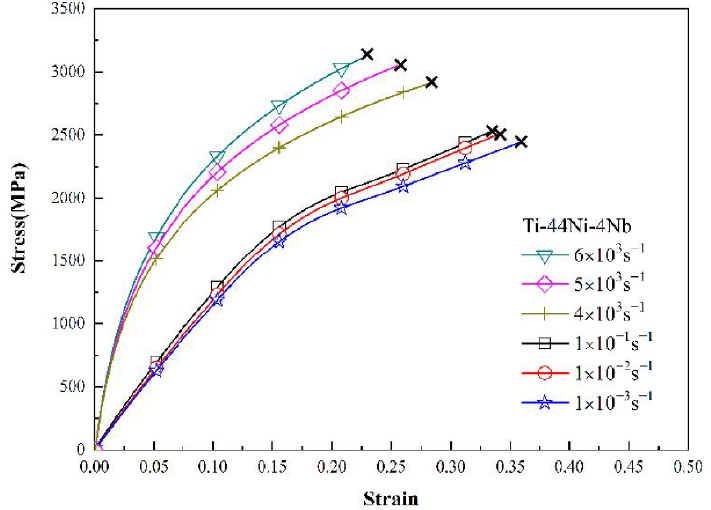
Figure 4. Low strain rate and high strain rate deformation curves of TiNi 44 Nb 4 alloy.